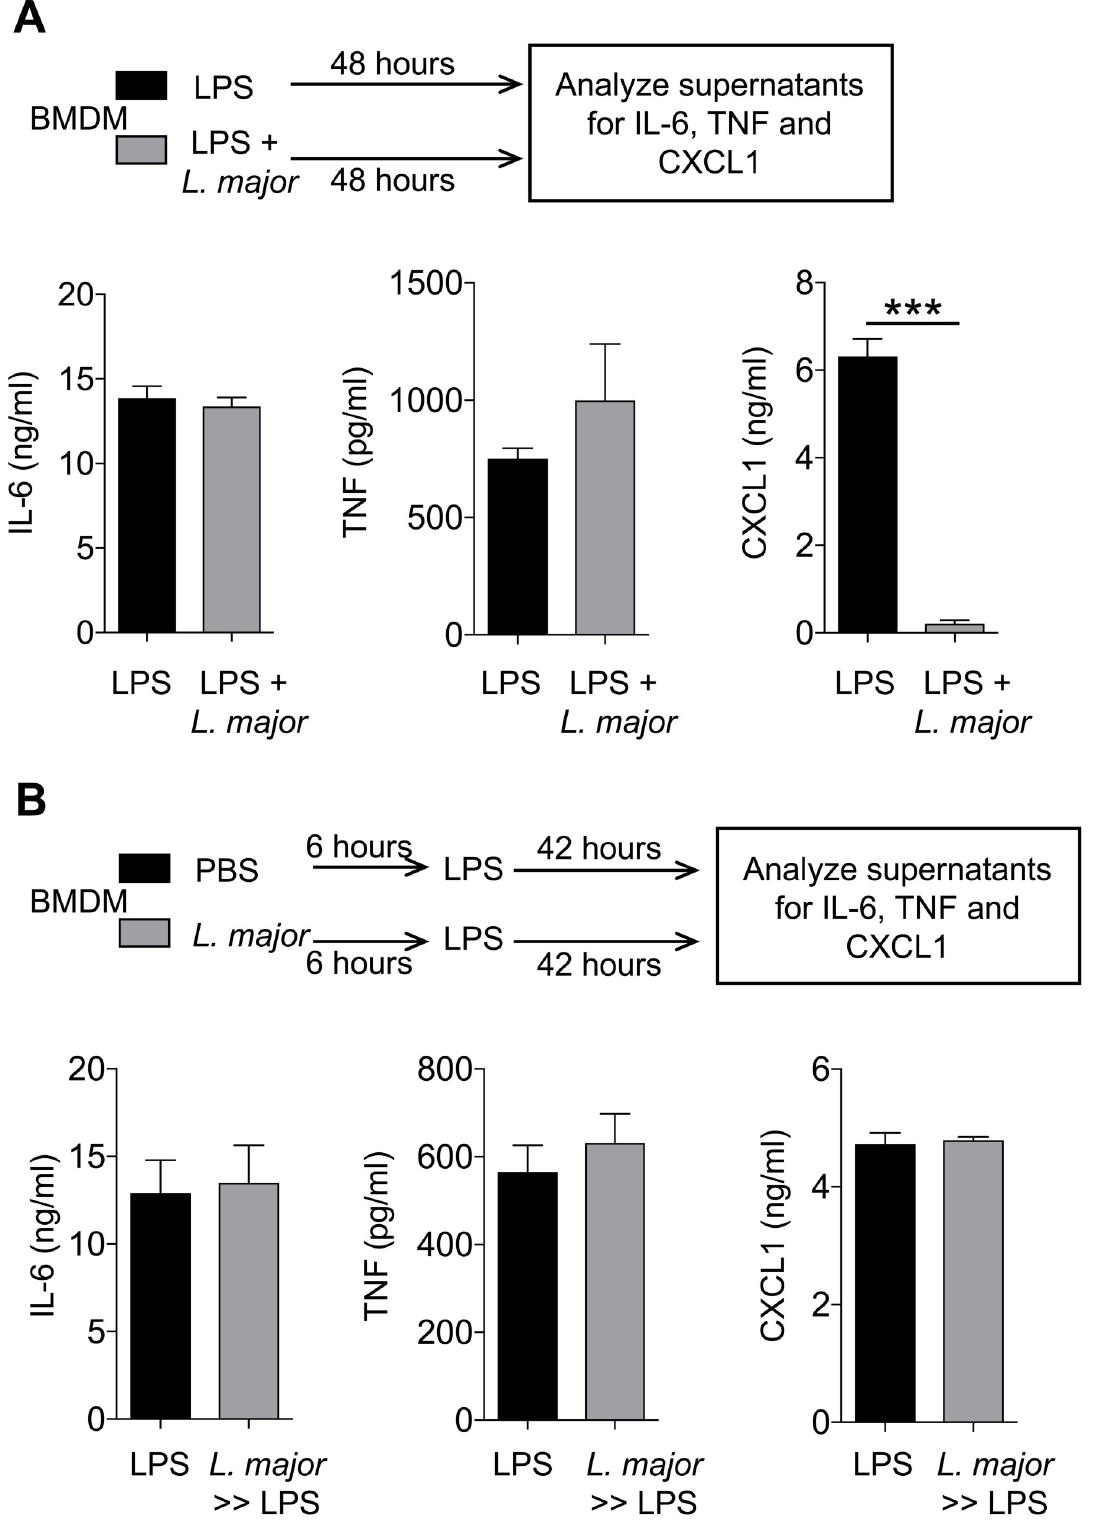
Fig 1. L . major diminishes LPS-induced CXCL1 release by BMDMs. (A) BMDMs were treated with LPS (20 ng/ml) in the presence or absence of L . major (20 MOI) for 48h and cell culture supernatants were analyzed for the indicated cytokines. (B) BMDMs were